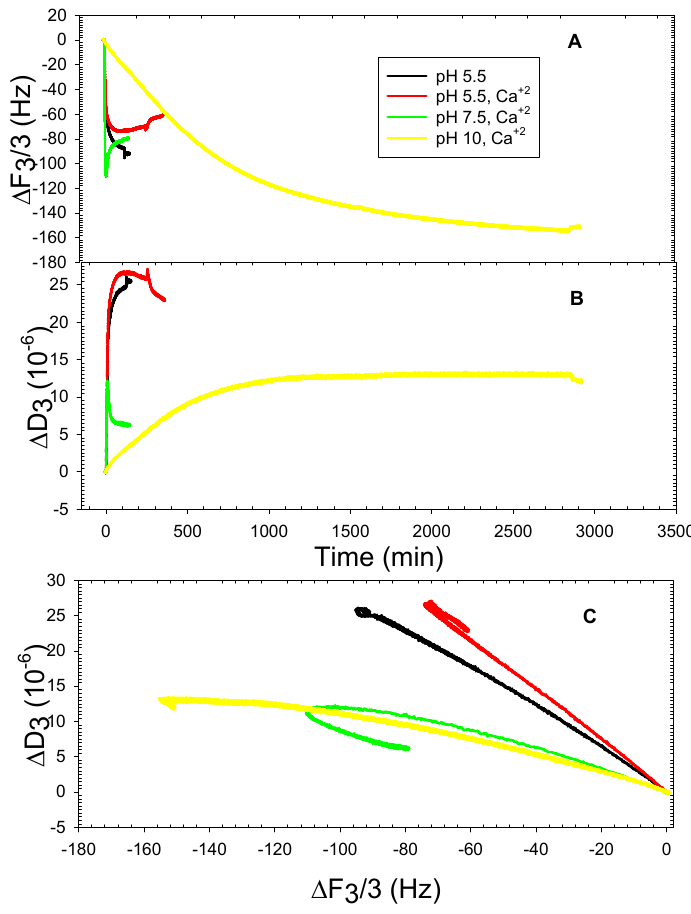
Figure 7. QCMD frequency ( A ) and dissipation ( B ) shifts representation of DOPG adsorption onto silica at pH 5.5, pH 7.5 and pH 10 in the absence and presence of 2 mM CaCl 2 ; ΔF vs. ΔD plot ( C ).